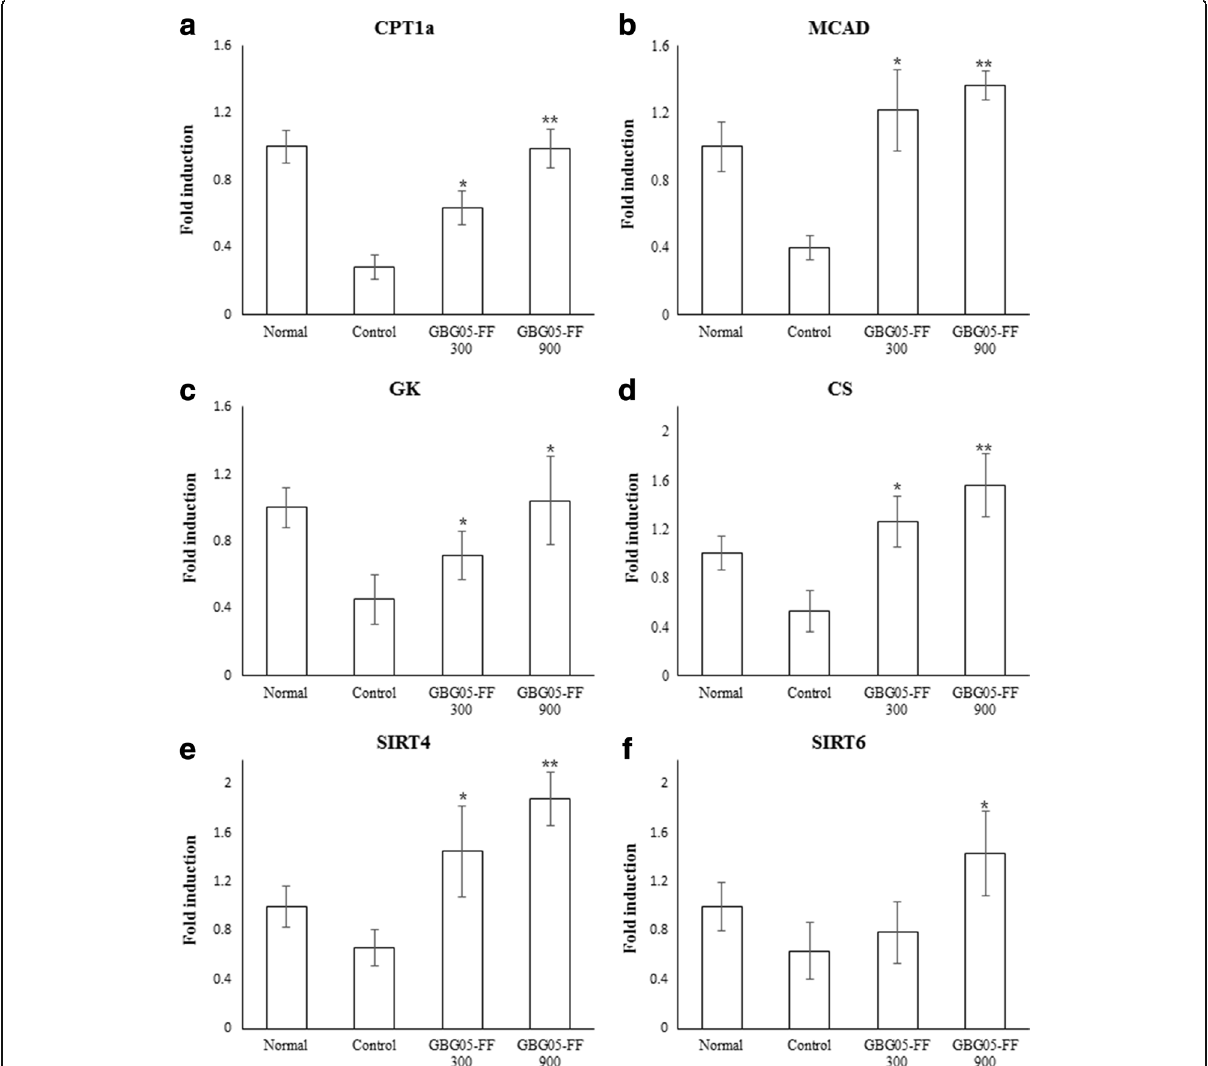
Fig. 8 Effects of GBG05-FF on the expression of CPT1 α ( a ), MCAD ( b ), GK ( c ), CS ( d ), SIRT4 ( e ) and SIRT6 ( f ) in the muscle of mice. Normal: dbh, Control: db/db, GBG05-FF 300: db/db fed the GBG05-FF 300 mg/kg, and GBG05-FF 900: db/db fed the GBG05-FF 900 mg/kg. Each value represents the mean ± SEM ( n = 10 per group) in three independent experiments. * P < 0.05, ** P < 0.01: Significant difference vs. control